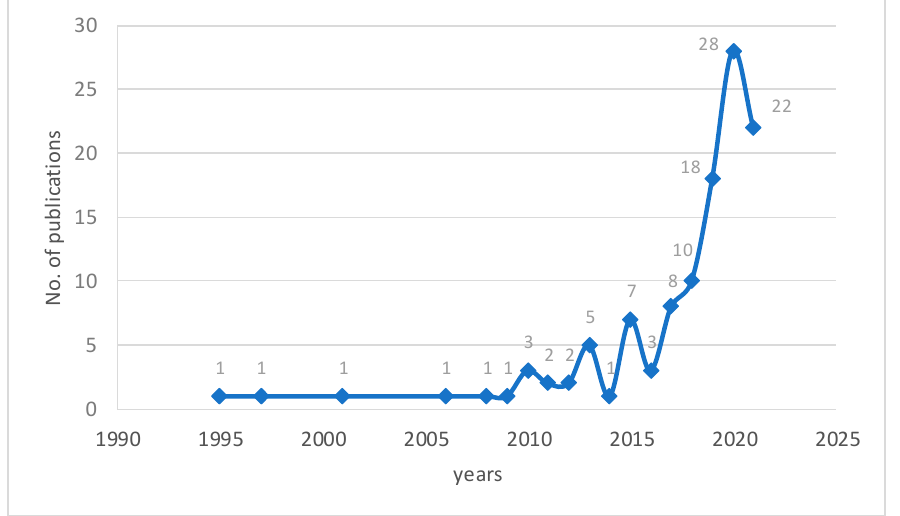
Figure 2. Annual publication trend of AI in civil engineering toward sustainable development.